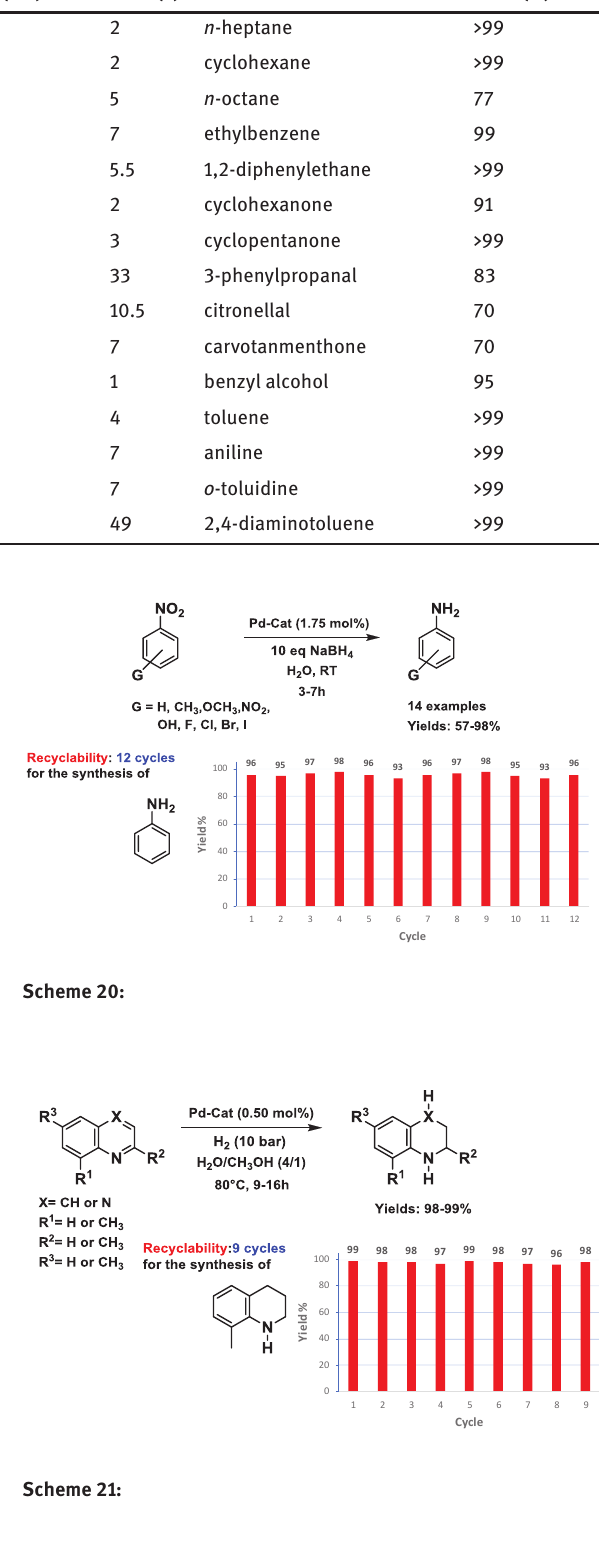
Table 3: Hydrogenation of unsaturated substrates catalyzed by Pd-cat (0.625% mol) at RT. Entry Substrate solvent